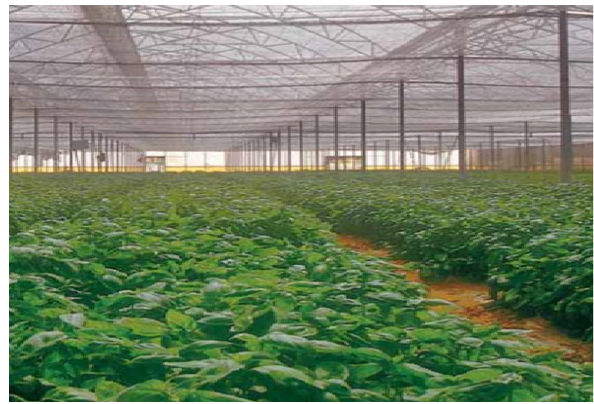
Figure 11: Greenhouse using HDPE fi bre - reinforced shade